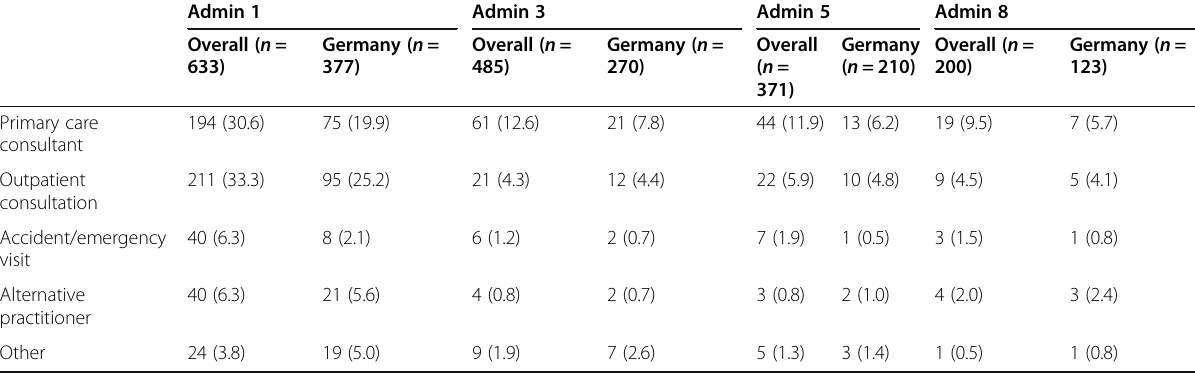
Table 2 Patient-reported visits to healthcare professionals by type of professional